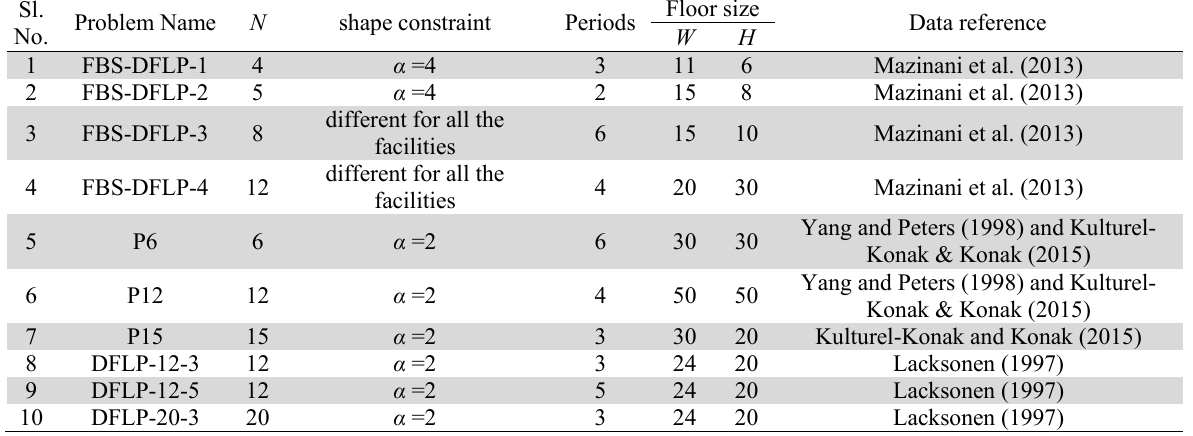
Summary unequal area dynamic facility layout problem data sets